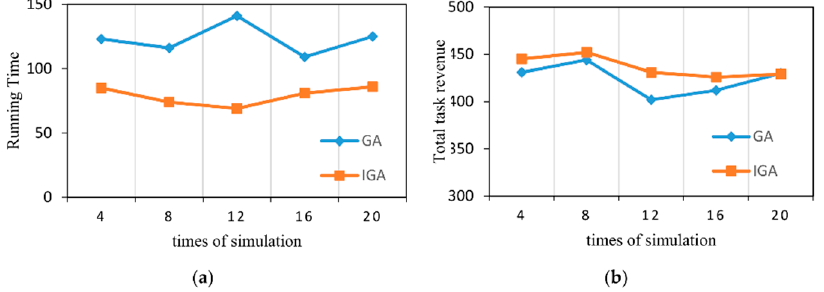
Figure 12. The result of Experiment 3. ( a ) The running time of Experiment 3 and ( b ) the task revenue of Experiment 3. Information 2018 , 9 , x